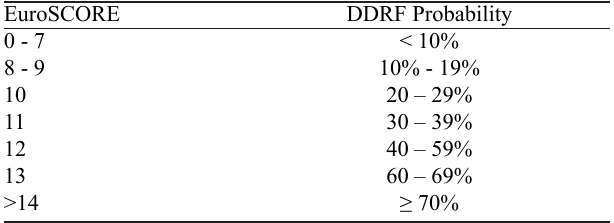
Table 10. Probability of developing DDRF according to EuroSCORE. Table 9. Probability of developing RTI according to